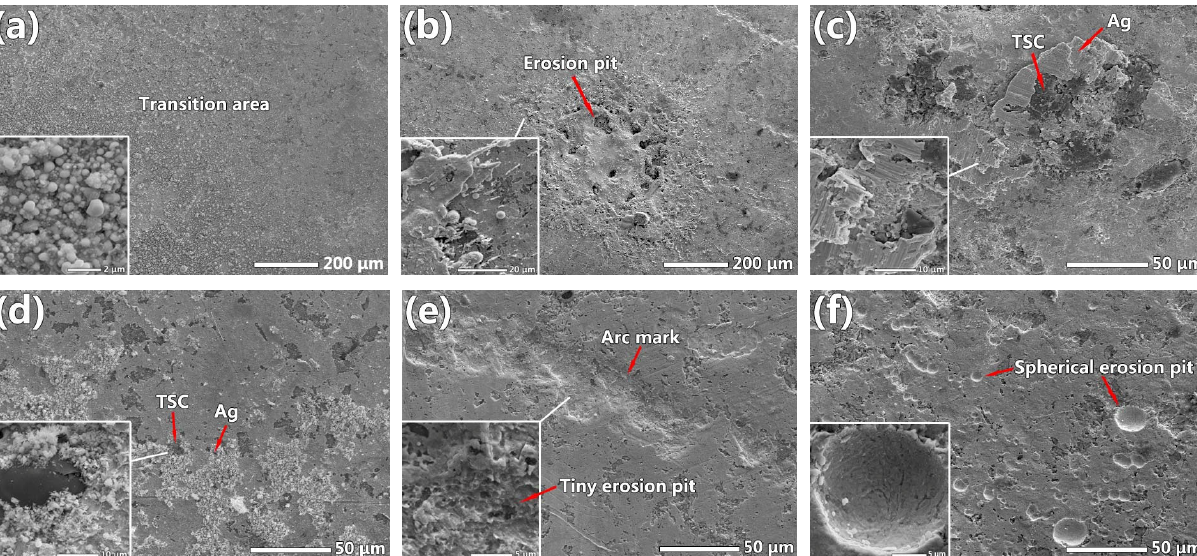
Fig. 5 Primary microstructure of the transition area on the contact surface of Ag/10TSC. (a) Transition area, and the inset shows the magnified image of the irregular Ag particles. (b) Large erosion pit and the arc marks, and the inset shows the magnified image on the edge of the erosion pit. (c) Ti 2 SnC particles surrounded by broken Ag blocks, and the inset shows the magnified image of the Ag blocks. (d) Ti 2 SnC particles encompassed by tiny Ag cluster, and the inset shows the magnified image of Ag cluster. (e) Arc mark, and the inset shows the magnified image of its inner. (f) Spherical erosion pit, and the inset shows its enlarged